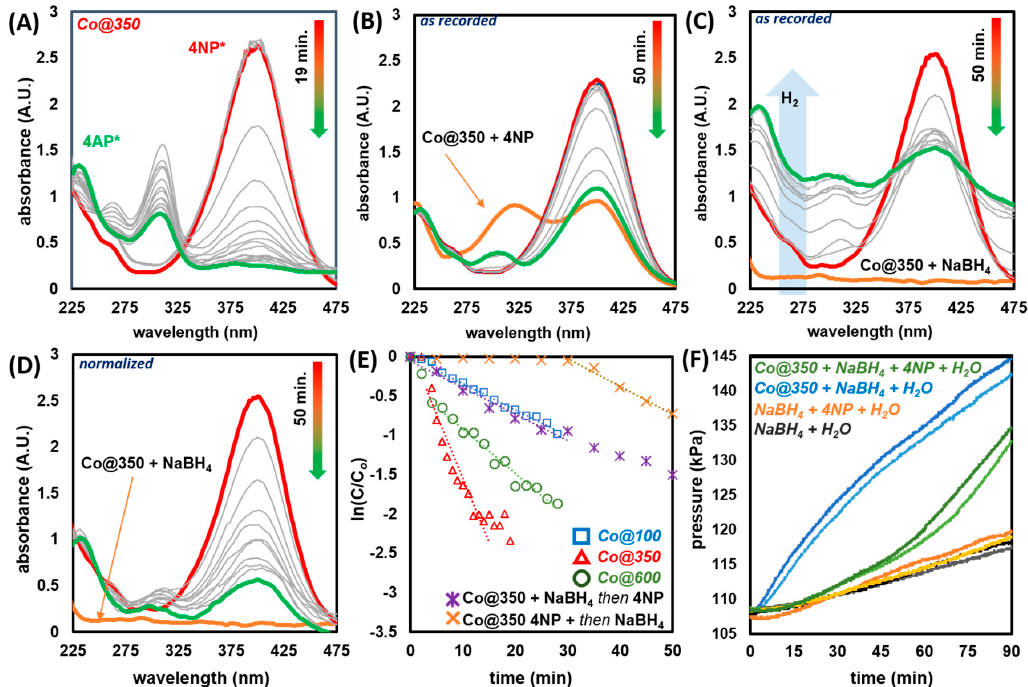
Figure 6. ( A ) UV-Vis spectra for the reduction of 4NP by Co 350 ; ( B ) Co@350 and 4NP, dwell 5 min, then, NaBH 4 addition; ( C ) Co@350 and NaBH 4 , dwell 5 min, then 4NP addition; ( D ) spectrum (C) normalized at 250 nm; ( E ) plot of ln(C/Co) as a function of time; and ( F ) change in pressure associated with the evolution of H 2 in closed system (repeat trials shown).